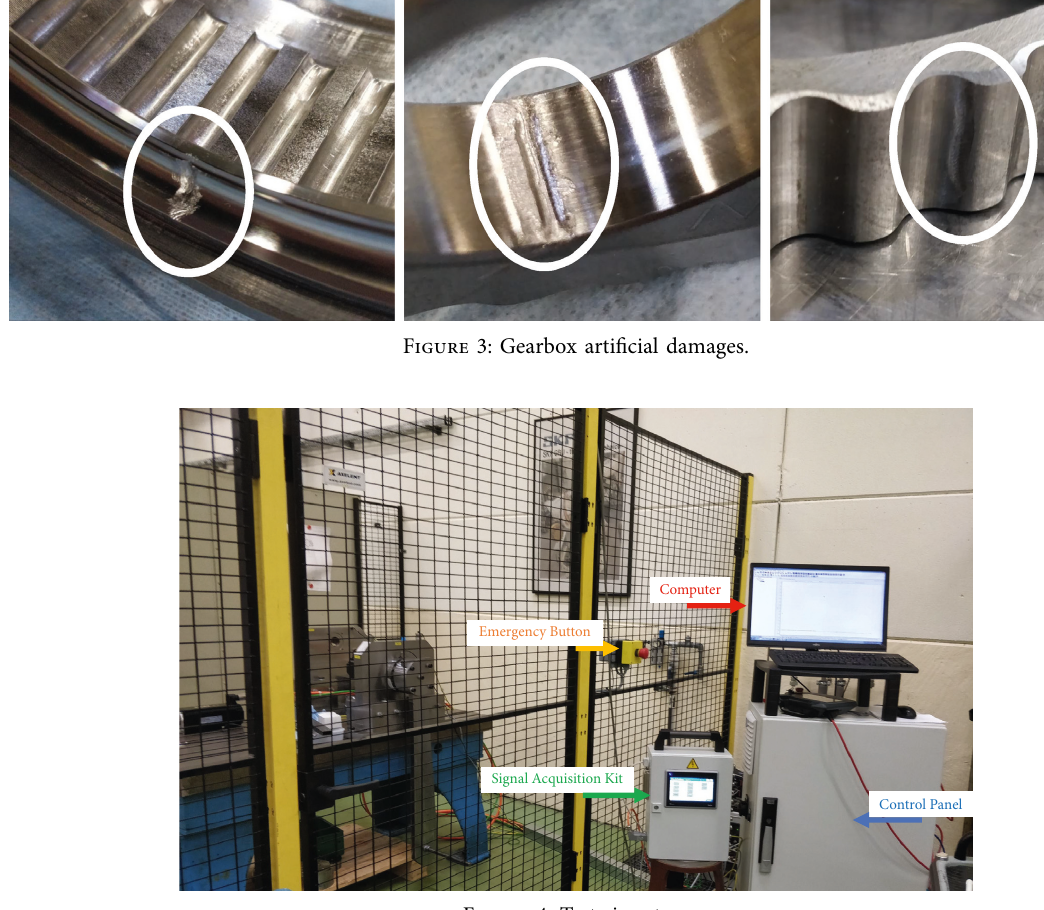
Figure 4: Test rig setup.